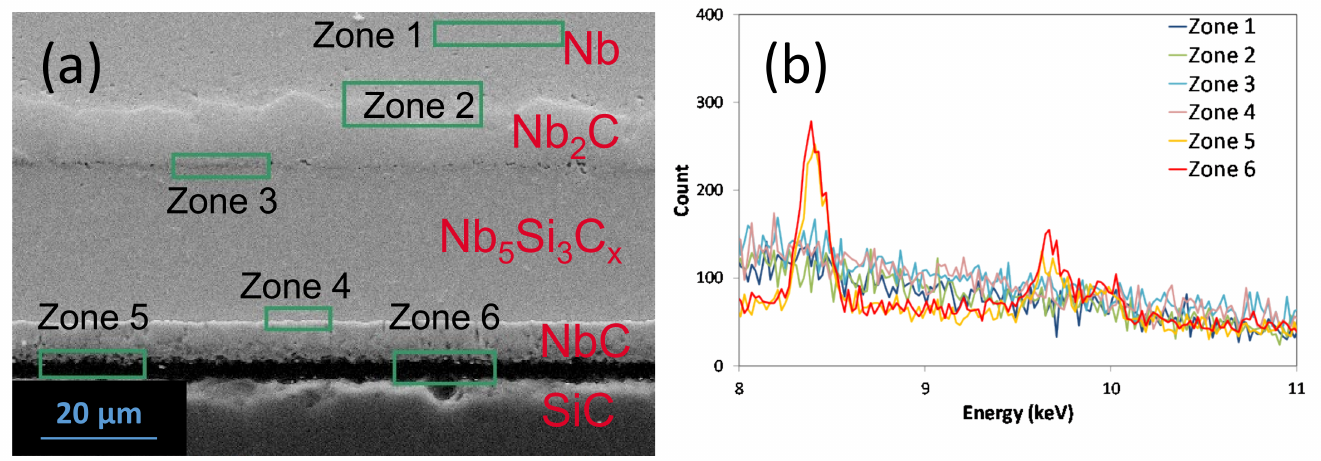
Figure 21. BSE-SEM ( a ) and EDX spectra ( b ) of the tungsten (L- α and L- β ) at several zones and interfaces in the Nb/SiC